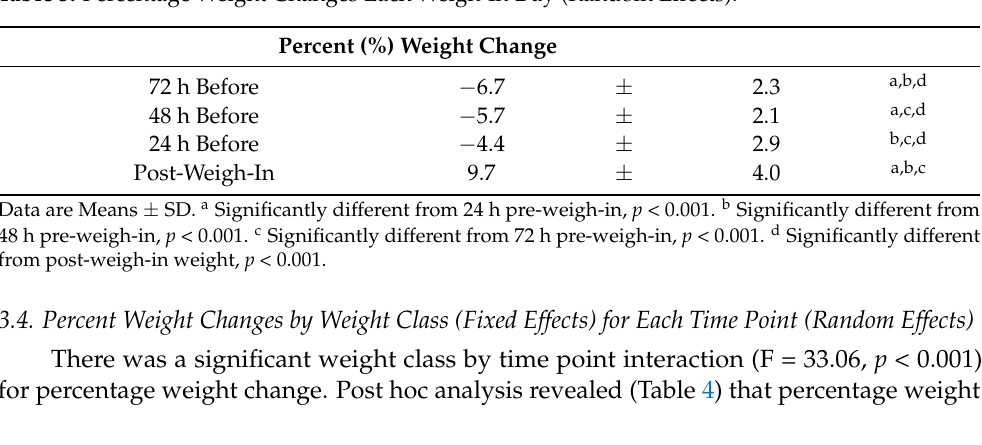
Table 3. Percentage Weight Changes Each Weigh-In Day (Random